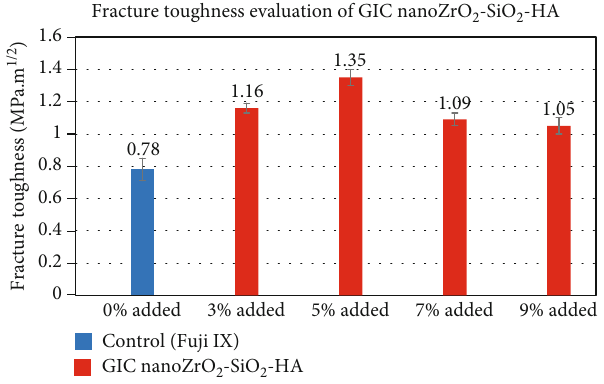
Figure 2: Fracture toughness evaluation of GIC nanoZrO